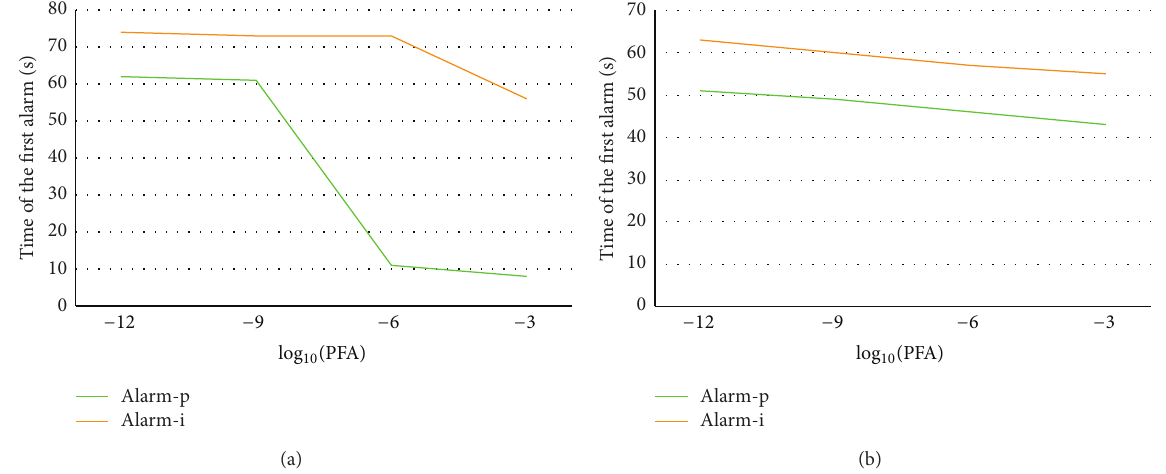
the green line ( persistence alarms ) in Font Roja (Figure